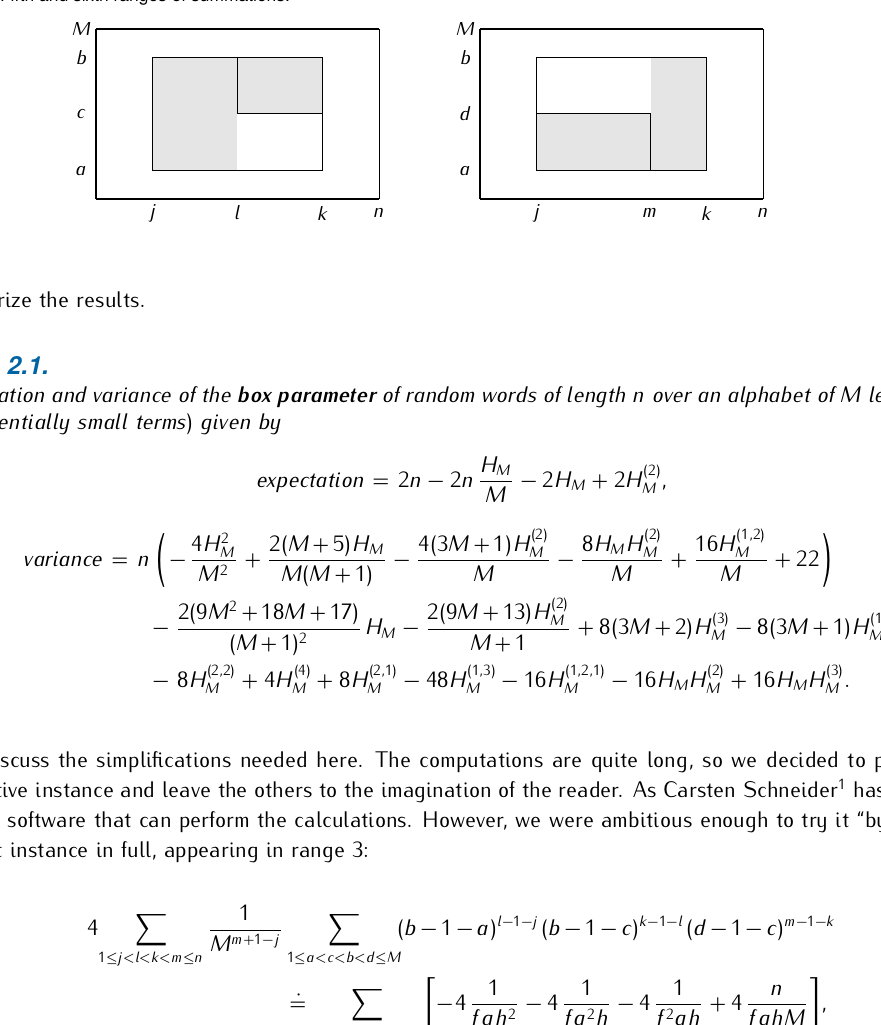
Figure 3. Fifth and sixth ranges of